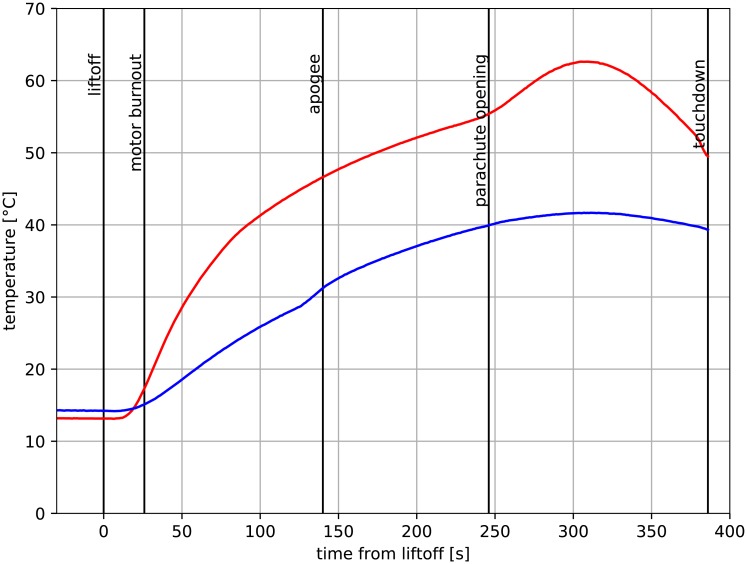
Temperature measured during flight [17].